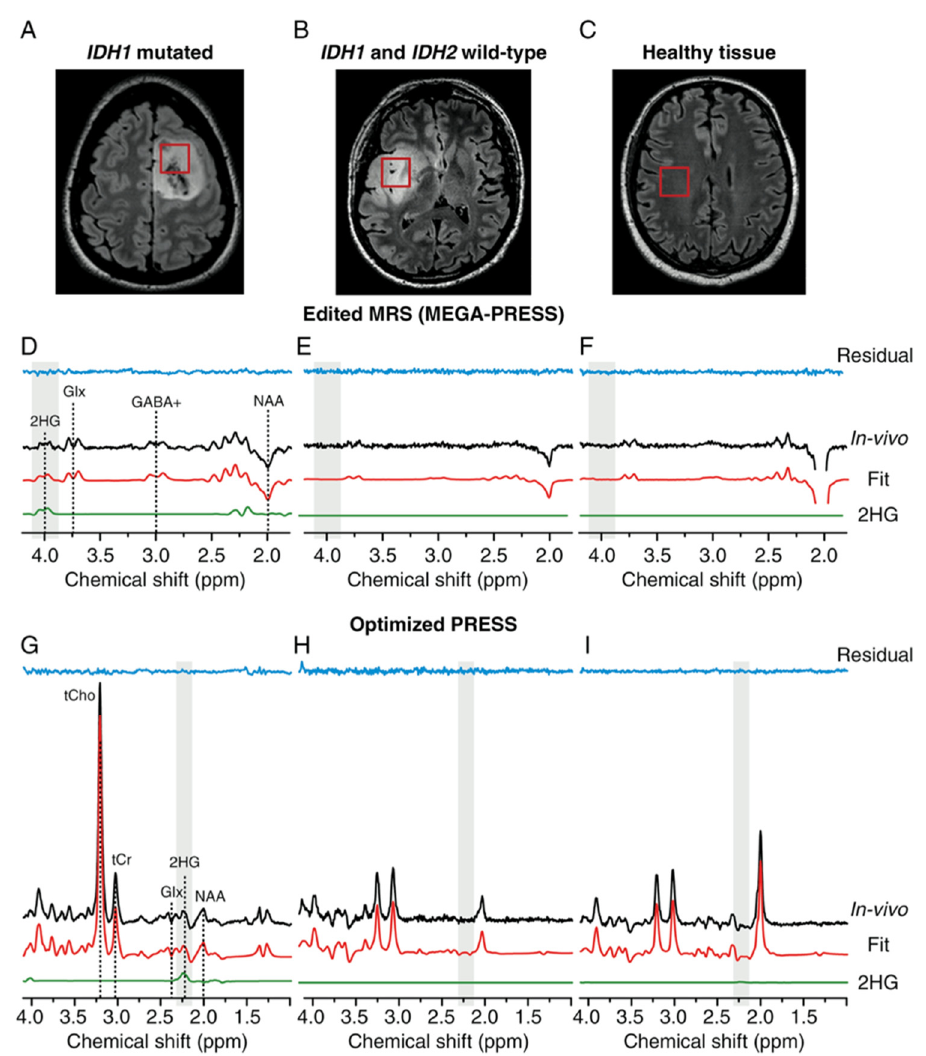
Figure 2. 2-Hydroxyglutarate (2HG) magnetic resonance spectroscopy (MRS) of one IDH mut -glioma (first column), one IDH wt -glioma (second column), and one healthy brain (third column). ( A , B , C ) Voxel localization on fluid attenuated inversion recovery (FLAIR) images; ( D , E , F ) evaluation of the secondary 2HG-peak at 4.02 ppm with the “edited” Mescher– Garwood point-resolved spectroscopy (MEGA-PRESS) sequence; ( G , H , I ) evaluation of the primary 2HG-peak at 2.25 ppm with the optimized PRESS sequence. Reproduced with permission from Branzoli et al.